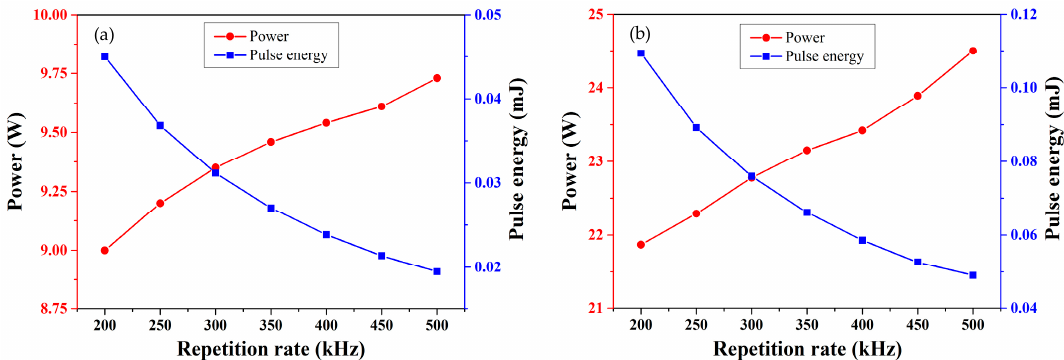
Figure 2. Average output power and pulse energy of the amplifier in dependence on the repetition rate of ( a ) regenerative amplifier output; and ( b ) final amplifier output.